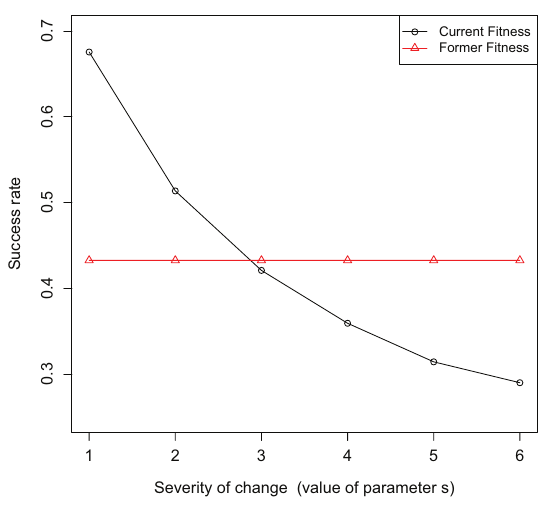
Fig. 2. Success rate of the prediction of the best global op- tima in the Moving Peaks Benchmark when the fitness of the local optima in the previous stage (former fitness series) and the fitness of their positions in the current stage (current fitness series) are considered